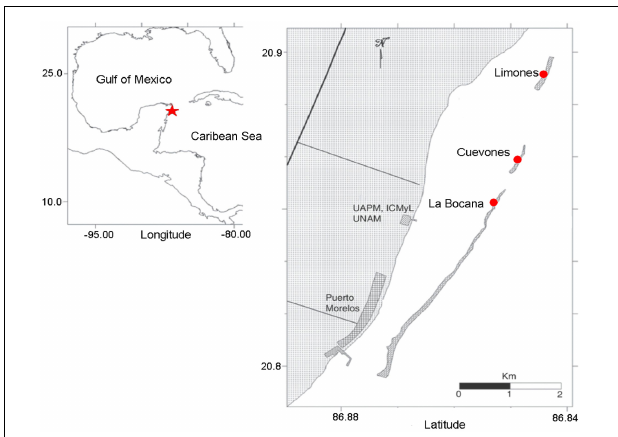
FIGURE 1 | The study area located in the Western Atlantic at Puerto Morelos Reef National Park, Mexico. The star denotes the location of the National Park and the circles show the location of the three study sties.